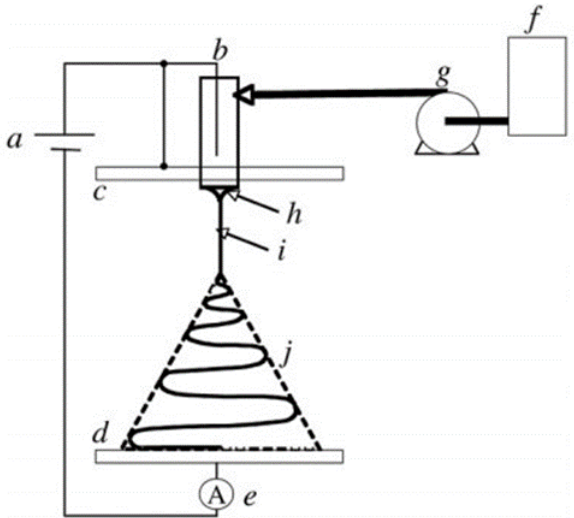
Figure 2. Schematic illustration of an experimental set up of a conventional electrospinning process: (a) high-voltage supply, (b) charging device of the spinneret, (c) high-potential electrode, (d) grounded collector, (e) current measurement device, (f) working solution reservoir, (g) flow rate control of the syringe pump, (h) Taylor’s cone, (i) thinning jet and (j) instability region. Reprinted with permission from [16] .